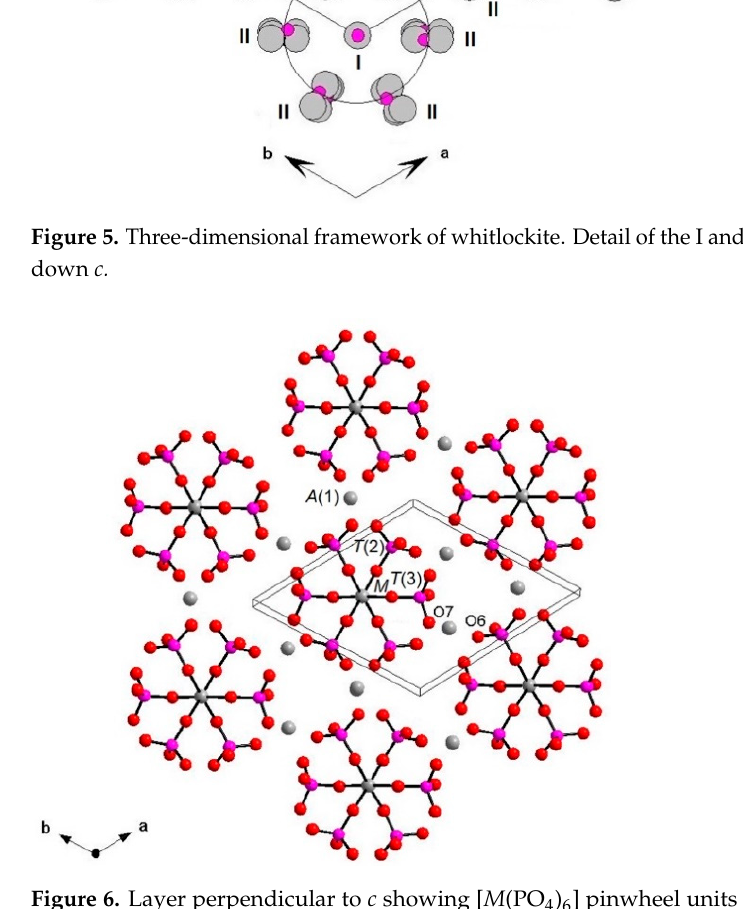
) ] pinwheel units [32]. A (2), A (3) and X sites 4 6